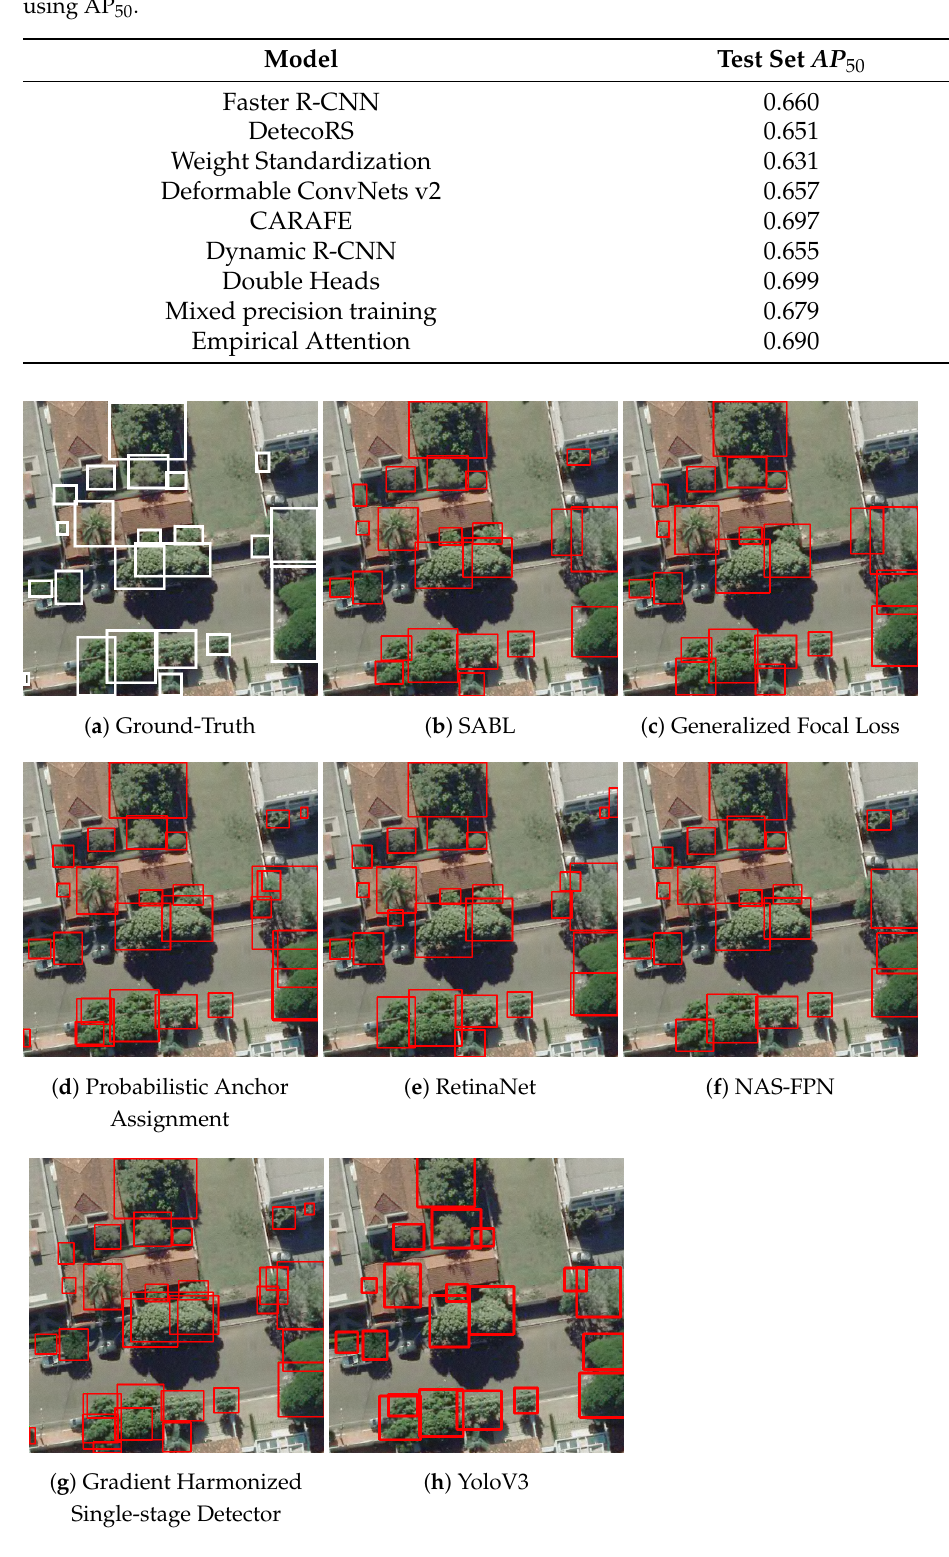
Figure 5. Examples of tree detection by the one-stage